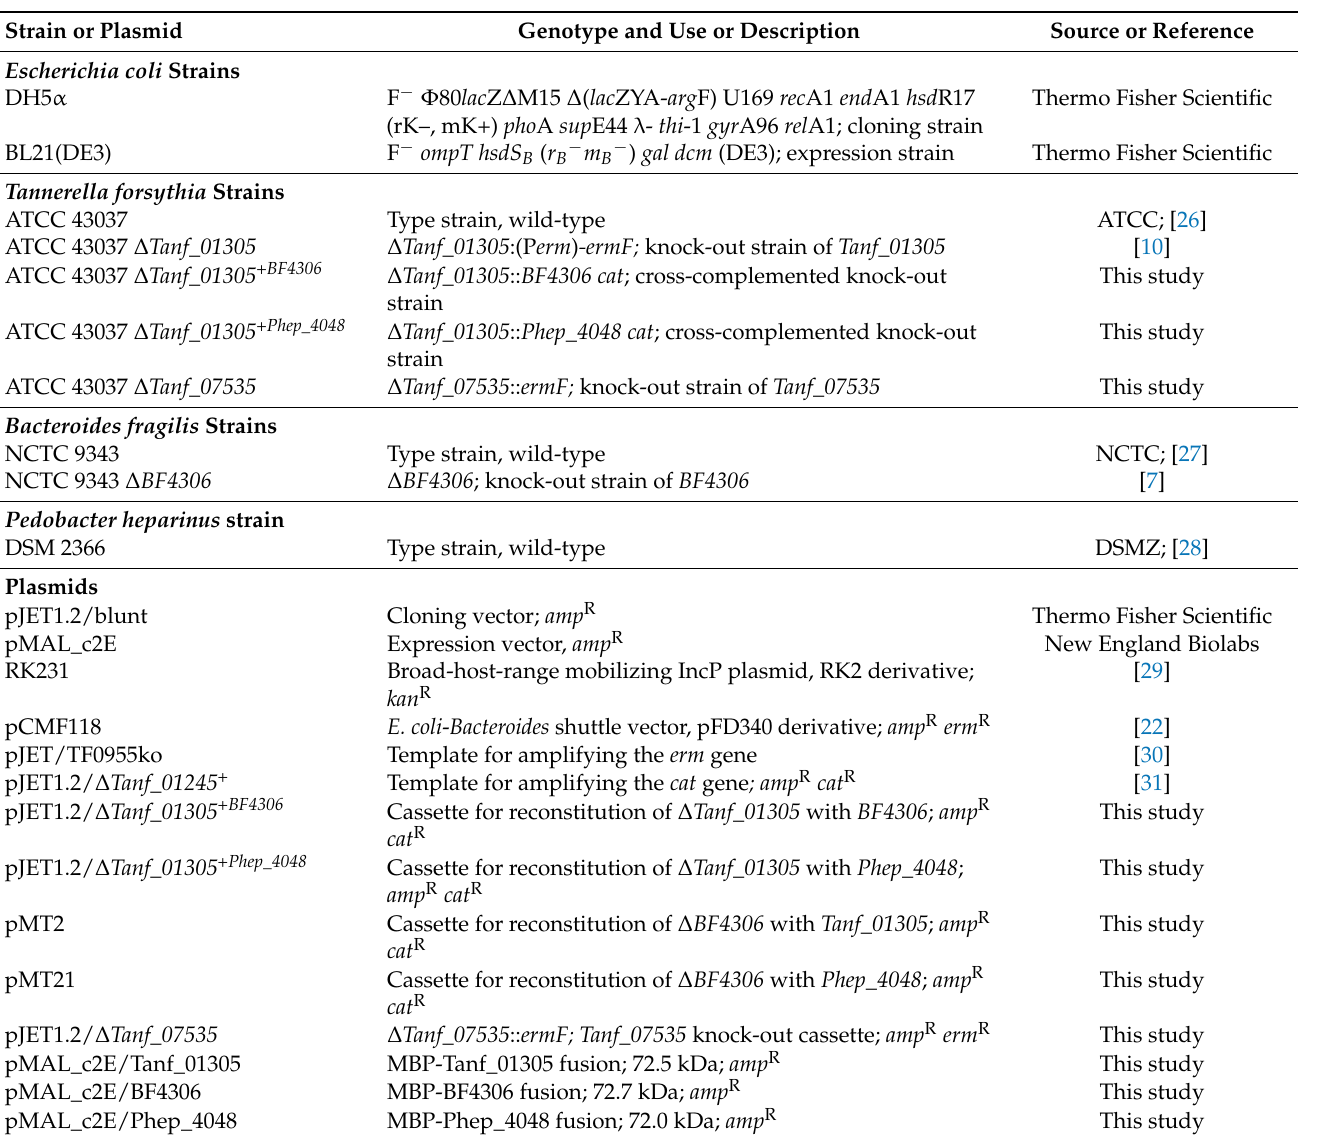
Table 1. Bacterial strains and plasmids used in this